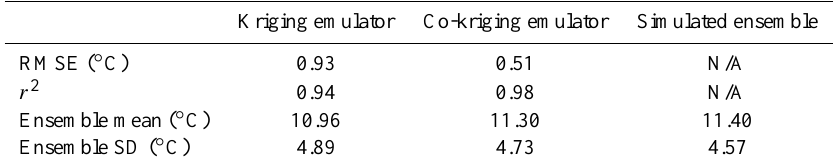
Table 3. Validation results for kriging and co-kriging emulators of PLASIM global mean SAT. The co-kriging emulator uses 50 expensive points and 200 cheap points while the kriging emulator here uses the same 50 expensive points.